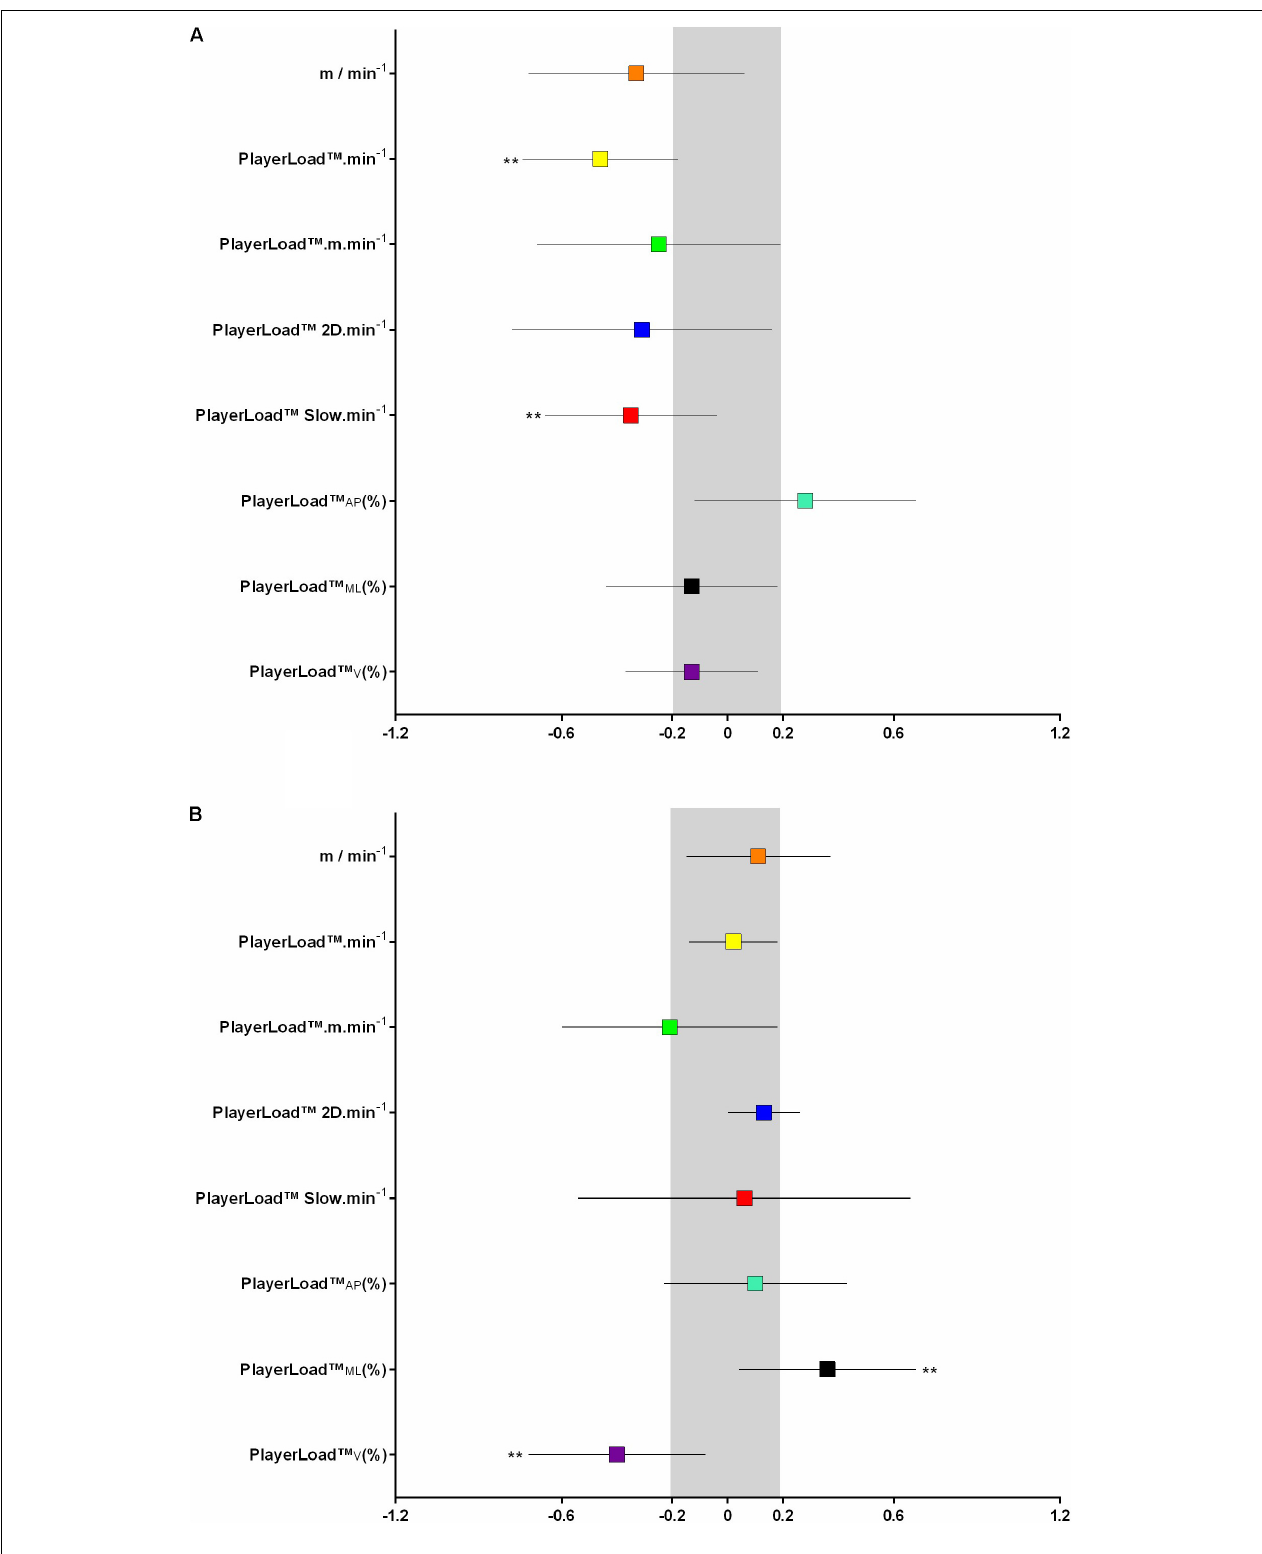
FIGURE 2 | Change in small-sided game; SSG activity profile metrics (A) and match exercise intensity (B) based on flight time:contraction time; FT:CT < and > baseline by more than the 8 %CV. Symbols denote a ∗∗ likely, ∗∗∗ very likley, and ∗∗∗∗ most likley chance that the change has exceeded the smallest worthwile change of 0.2 (shaded in